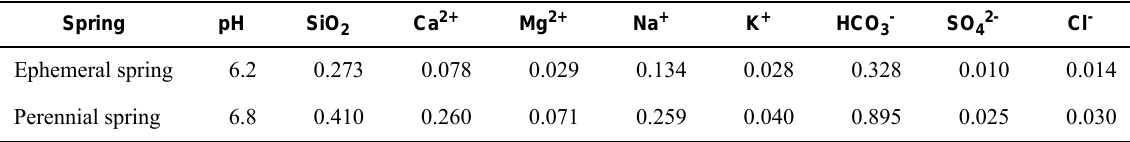
Table 45. Analytical data for spring waters in example